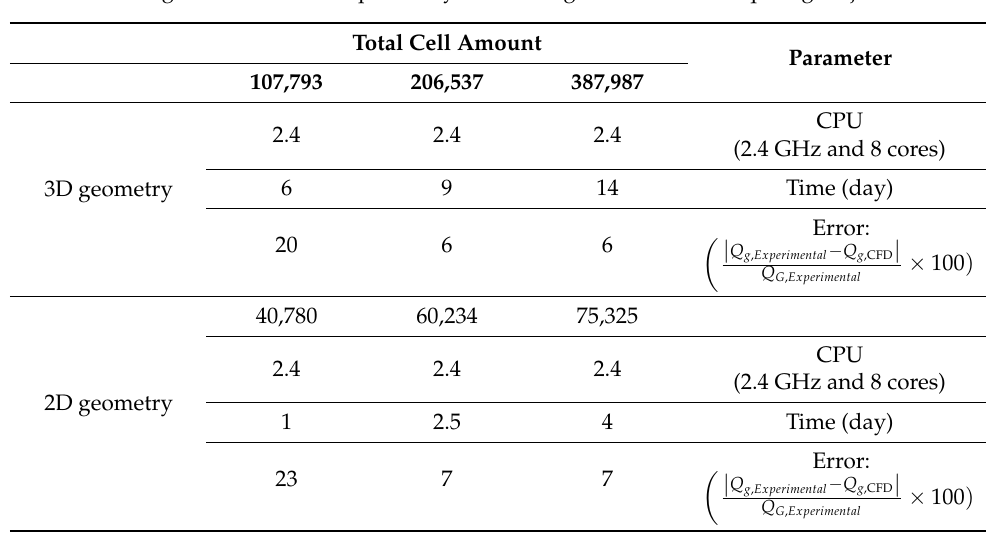
Figure 3. Dimensions , grid structures, and boundary conditions of 3D and 2D ejector. Table 2. Investigation of mesh independency of the designed 3D and 2D liquid–gas